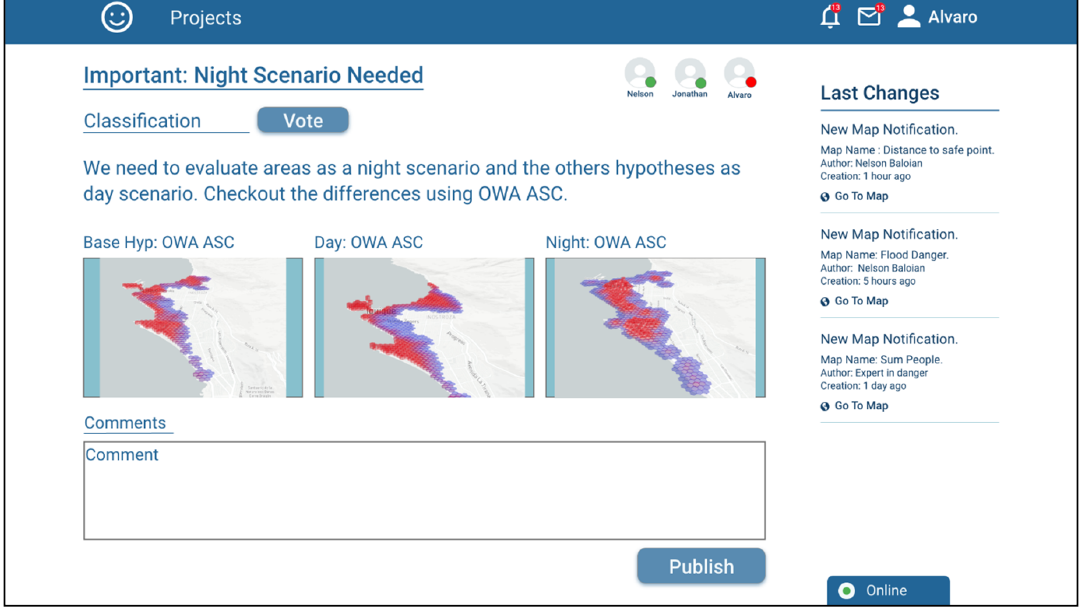
Figure 11. Screenshot of the voting and commenting function of the application.